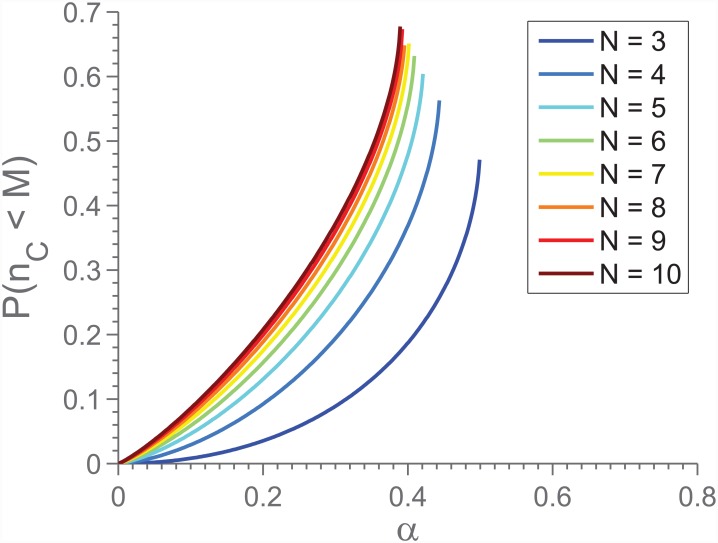
The probability of having insufficient cooperators as a function of N, for M = 2, assuming that 〈x〉 is equal to the upper root of Eq (2), as predicted by the mean field theory.Note that the different extents of the lines (i.e. that N = 9 covers a smaller part of the α-axis than N = 3) stem from the limitations of the mean field model.